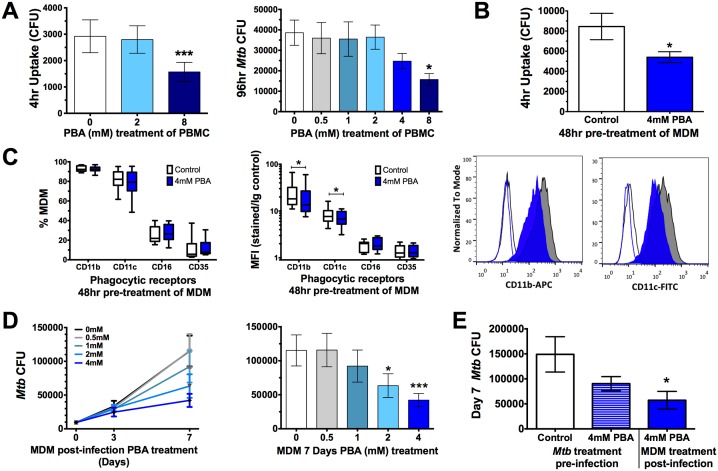
PBA resticts Mtb uptake and intracellular growth in PBMC and MDM.(A) Uptake of Mtb H37Rv by PBMC 4 hrs post-infection and intracellular growth 96 hr-post-infection in the presence of a 2-fold serial dilution of PBA. (B) Mtb uptake by MDM pre-treated with 4mM PBA for 48 hrs. (C) Phagocytic receptor expression (CD11b, CD11c, CD16 or CD35) on MDM following 48 hrs 4mM PBA treatment:percent of live cells expressing receptors and median fluorescent index (MFI), by flow cytometry. (D) Intracellular Mtb growth in MDM treated with a serial dilution of PBA 4 hrs post-infection, measured by CFU. (E) Seven day intracellular growth of 4mM PBA pre-treated Mtb, and control Mtb, grown in MDM ± 4mM PBA post-infection. Mean ± SD or min-max (box plots), n = 3–4 in triplicate for CFU and n = 8 for flow cytometry; 1-way ANOVA with Dunnett’s multiple comparisons test (A,E,F) or Paired t-test (B,C,D): *, P<0.05, ***, P<0.001.